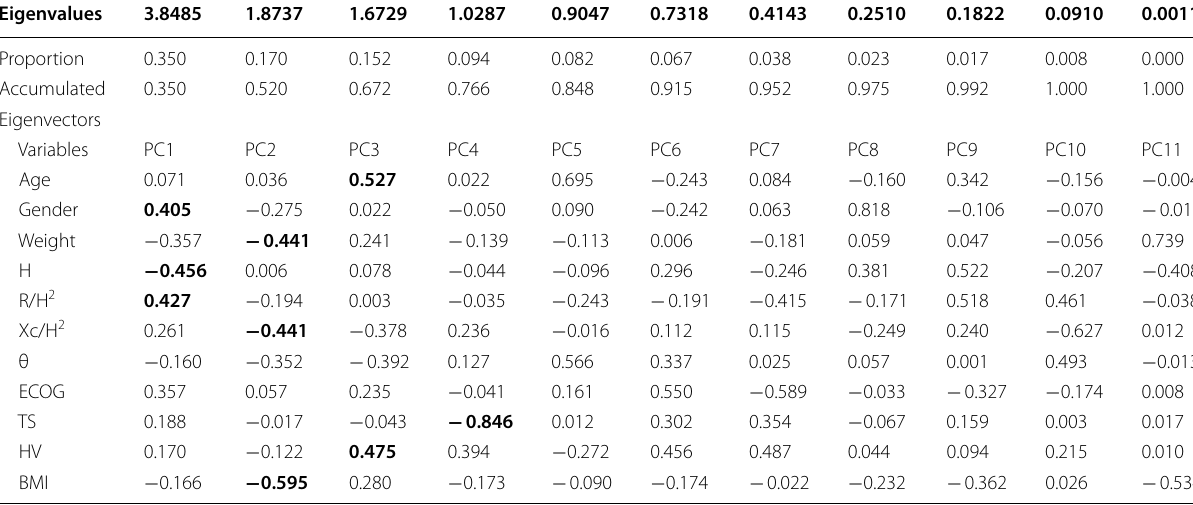
Table 8 Eigenvalues and eigenvectors of the correlation matrix of 11 independent variables considering R/H 2 and Xc/H